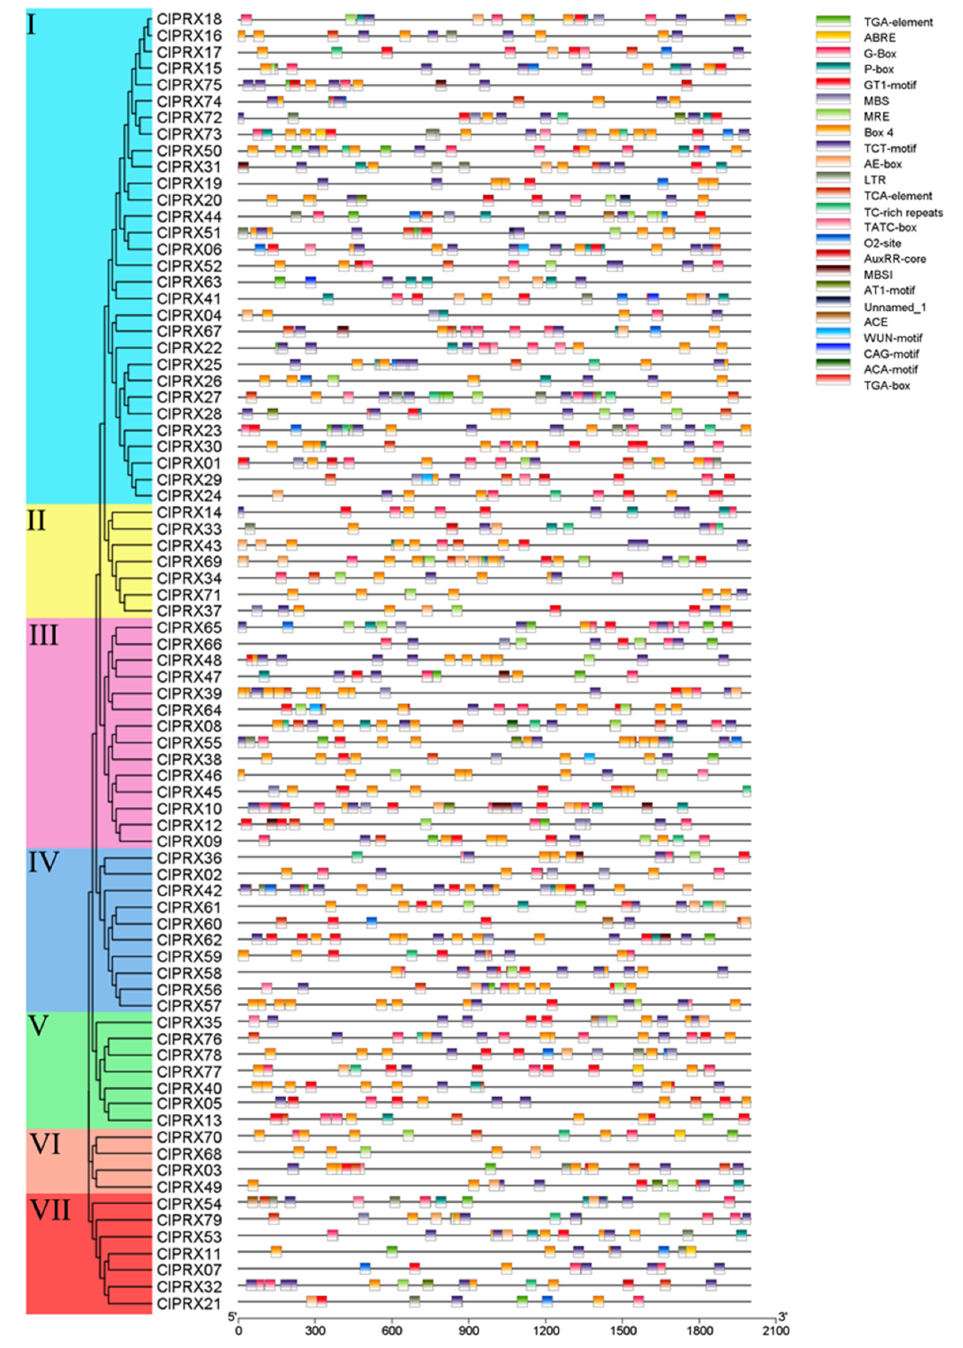
Figure 8. The cis-acting element analysis of the ClPRXs’ promoter.